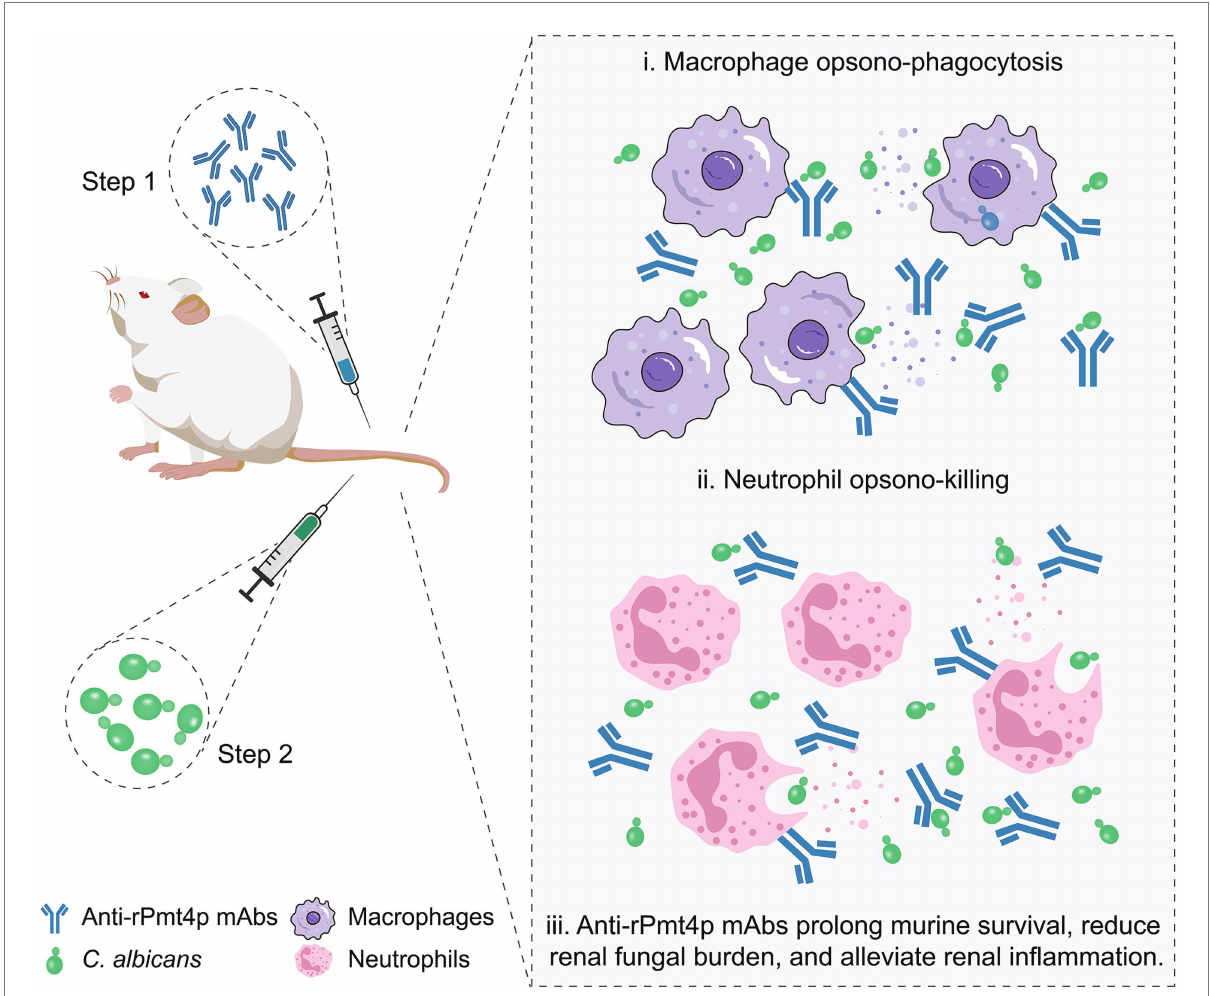
FIGURE 6 A schematic illustration of anti-rPmt4p mAbs eliciting beneficial effects in the murine model of disseminated candidiasis. The mAbs exert protective effects via a mechanism that involves mAb-induced macrophage opsonophagocytic (i) and neutrophil killing activities (ii). Prophylactic mAb administration prolongs the survival time, reduces the fungal burden, and alleviates renal inflammation in mice with disseminated candidiasis